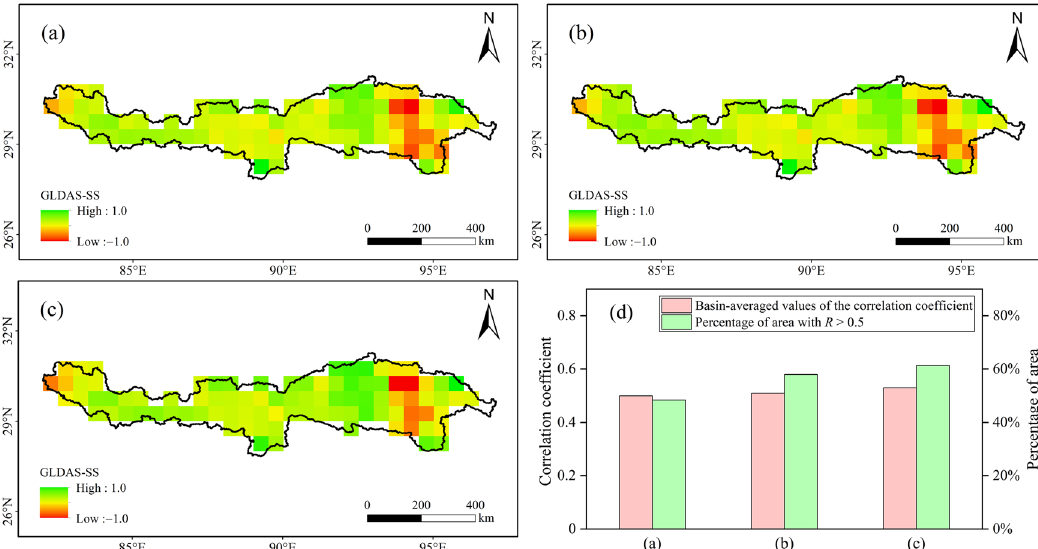
Figure A1. Results of sensitivity analysis on influencing factors of TWSC based on GLDAS-SS. ( a ) represents the spatial distribution of correlation coefficient between GLDAS-SS-derived TWSC (taking soil moisture, snow water equivalent, surface water, groundwater, and plant canopy interception into account) and GRACE-derived TWSC; ( b ) represents the spatial distribution of correlation coefficient between GLDAS-SS-derived TWSC (taking soil moisture, snow water equivalent, and groundwater into account) and GRACE-derived TWSC; ( c ) represents the spatial distribution of correlation coefficient between GLDAS-SS-derived TWSC (taking soil moisture and snow water equivalent into account as defined in SS method in this study) and GRACE-derived TWSC; ( d ) illustrates the comparison results among ( a – c ).